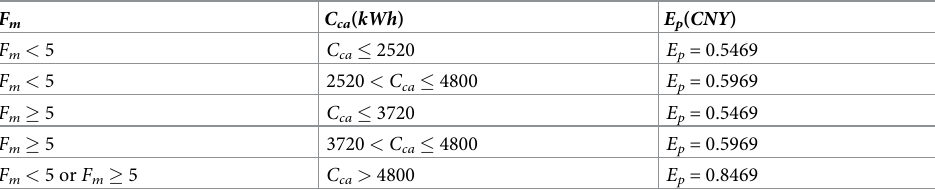
Table 2. Electricity price